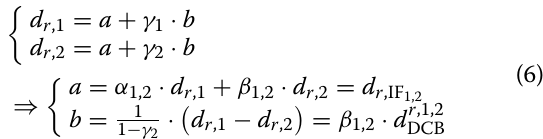
FF3: model with three dual‑frequency IF